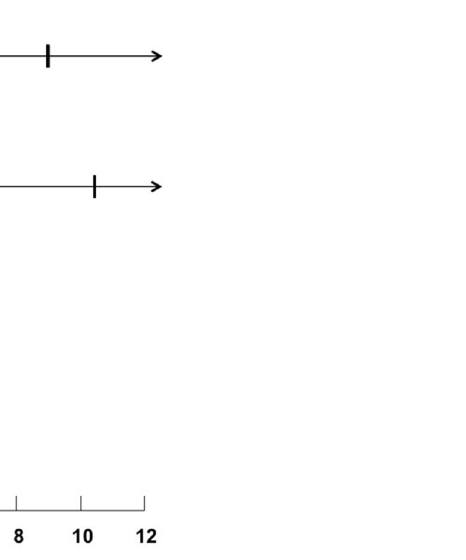
Figure 2. Flow chart of patients